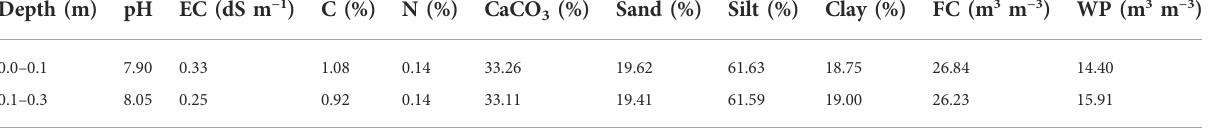
TABLE 1 Soil characteristics at the fi eld site.